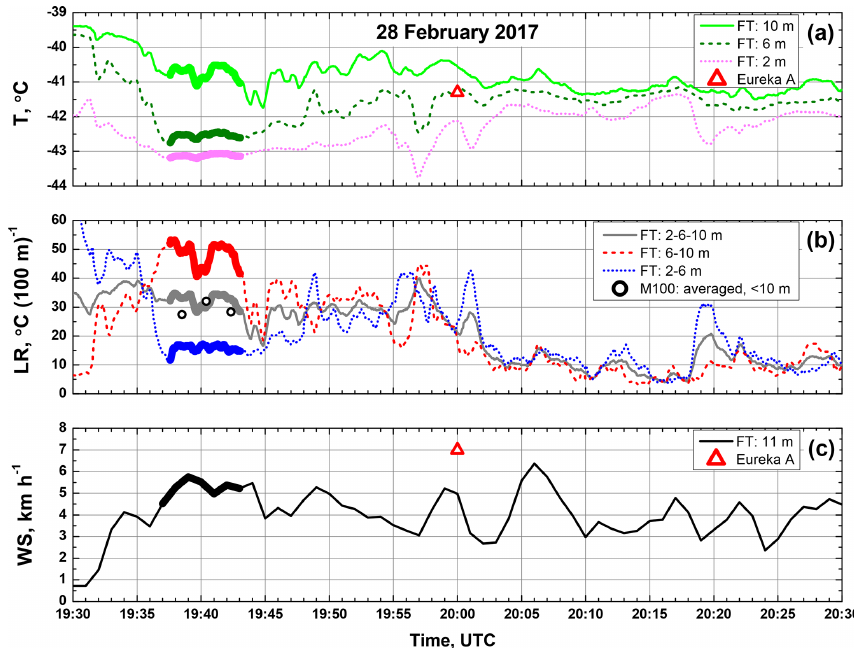
Figure 6. Time evolution of (a) air temperatures ( T ) from the FT 2, 6, and 10m RTDs and the Eureka A sensor, (b) FT and M100 SBI lapse rates (LR), and (c) wind speed (WS) from the 1min FT 11m wind vane and Eureka A anemometer between 19:30 and 20:30UTC on 28 February 2017. The FT data taken during the time frame of three sets of M100 ascents and descents (19:37–19:43UTC) are highlighted by thicker